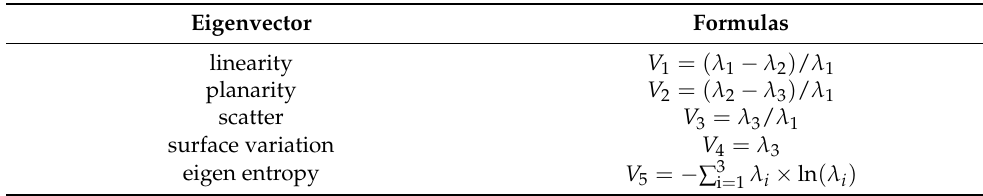
Table 1. Calculation formulas of